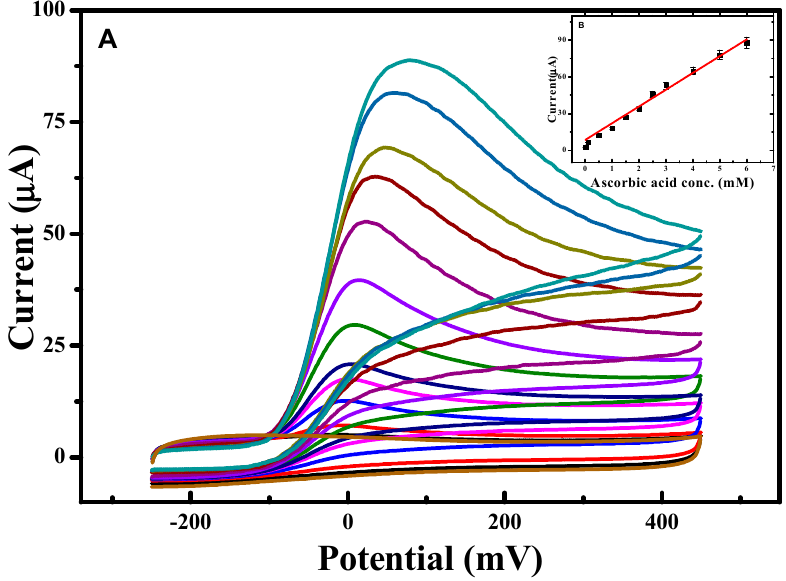
Figure 8. ( A ) CVs obtained at various concentrations of ascorbic acid prepared in PBS, pH 7.0 at scan rate of 10 mV/s; and ( B ) calibration plot showing concentration of ascorbic acid prepared in PBS, pH 7.0 at scan rate of 10 mV/s.